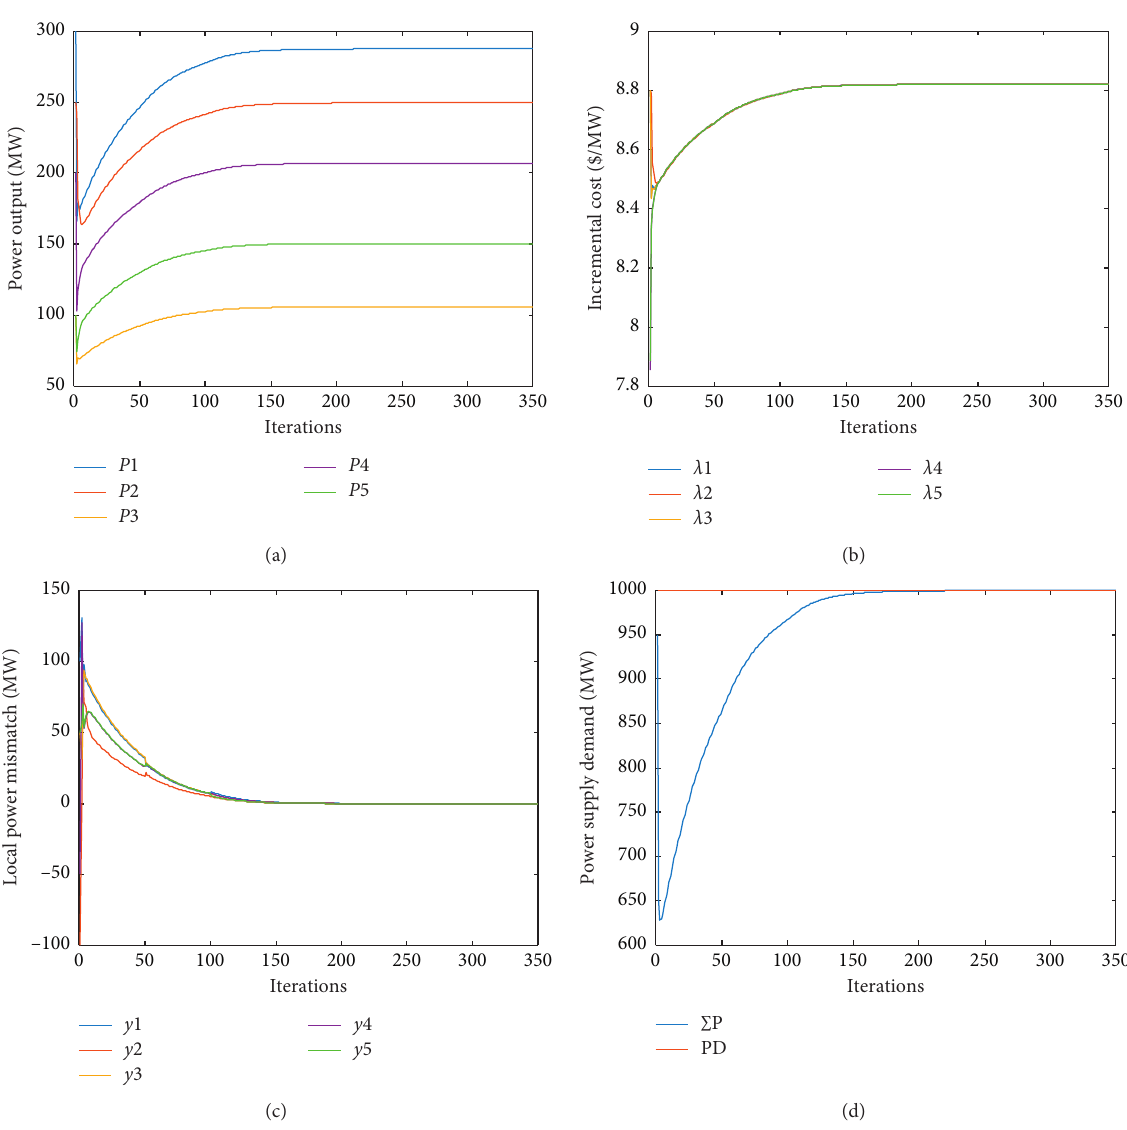
Figure 4: EDP with strongly connected topology under DoS attacks. (a) The power output of each generator. (b) The incremental cost of each generator. (c) Auxiliary variable y of each generator. (d) Total power output and load